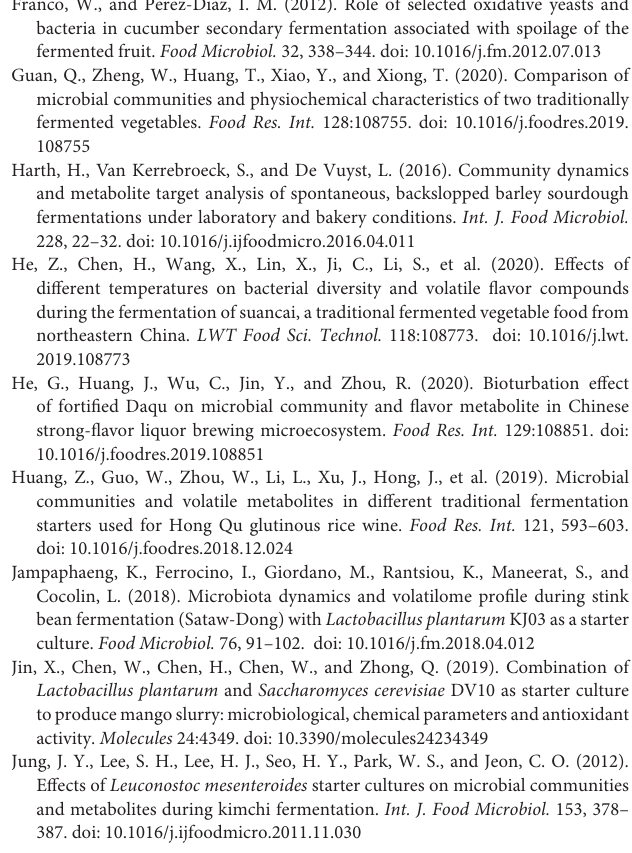
TABLE S1 | The detailed concentration of volatile metabolites in different homemade northeast sauerkraut at days 0 and 30. #1, #2, and #3 represented three different households. The number behind “ − ” (0, 30) represented fermentation time (day). RT, retention time; Total, the total concentration of each class of volatile metabolites. Mean values in the Total row with different superscripted letters indicate that they are significantly different at p < 0.05. ANOVA analysis was performed using Tukey’s test. TABLE S2 | Detailed quantitative information of each free amino acids (FAAs) in different homemade northeast sauerkraut at days 0 and 30. #1, #2, and #3 represented three different households. The number behind “ − ” (0, 30) represented fermentation time (day). Total, the total concentration of 18 FAAs identified in this study. Mean values in the same row with different superscripted letters indicate that they are significantly different at p < 0.05. ANOVA analysis was performed using Tukey’s